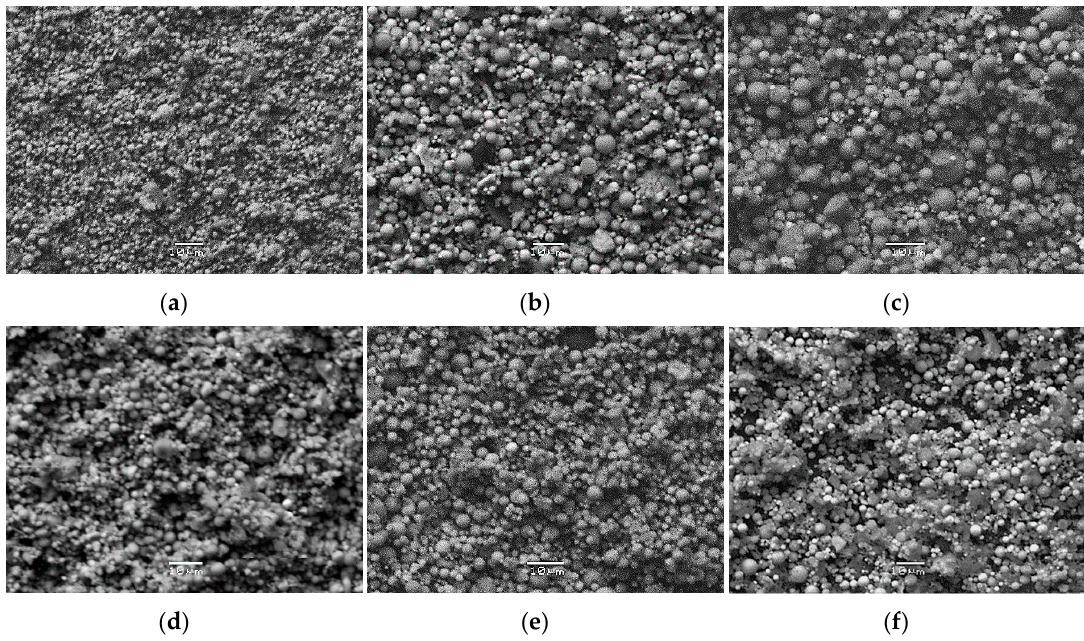
Figure 6. SEM pictures from stage 15 for experiments: ( a ) C2; ( b ) B2; ( c ) A2; ( d ) C1; ( e ) B1; ( f ) A1.